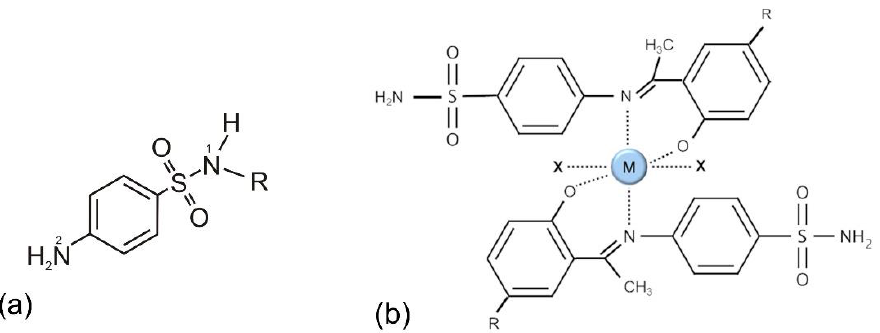
Figure 6. ( a ) General structure of sulfonamides. ( b ) Chelation is not relevant in the classical sulfon- amide mode of action, but the chelates of new-generation sulfonamide molecules with metal (M) cations (M = Co 2+ , Ni 2+ , Cu 2+ , Zn 2+ , and VO 2+ ) demonstrate antibacterial and antioxidative activities; inspired by ref. [49].